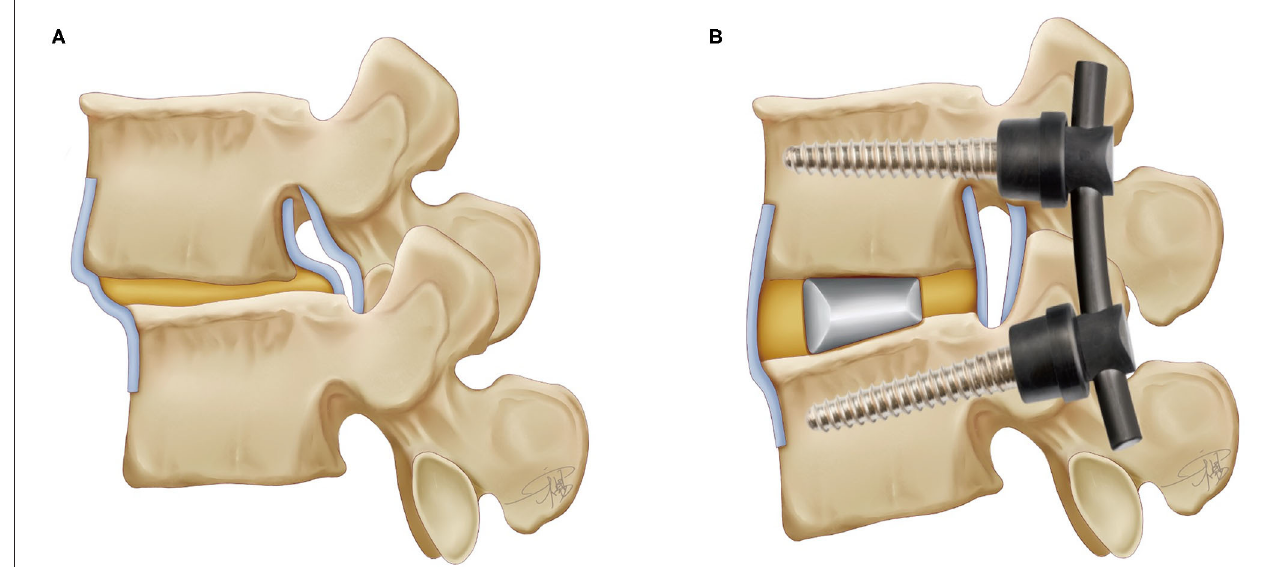
FIGURE 4 | The lumbar spine model and the instrumentations after TLIF technique (the interbody fusion cage and the pedicle screw).